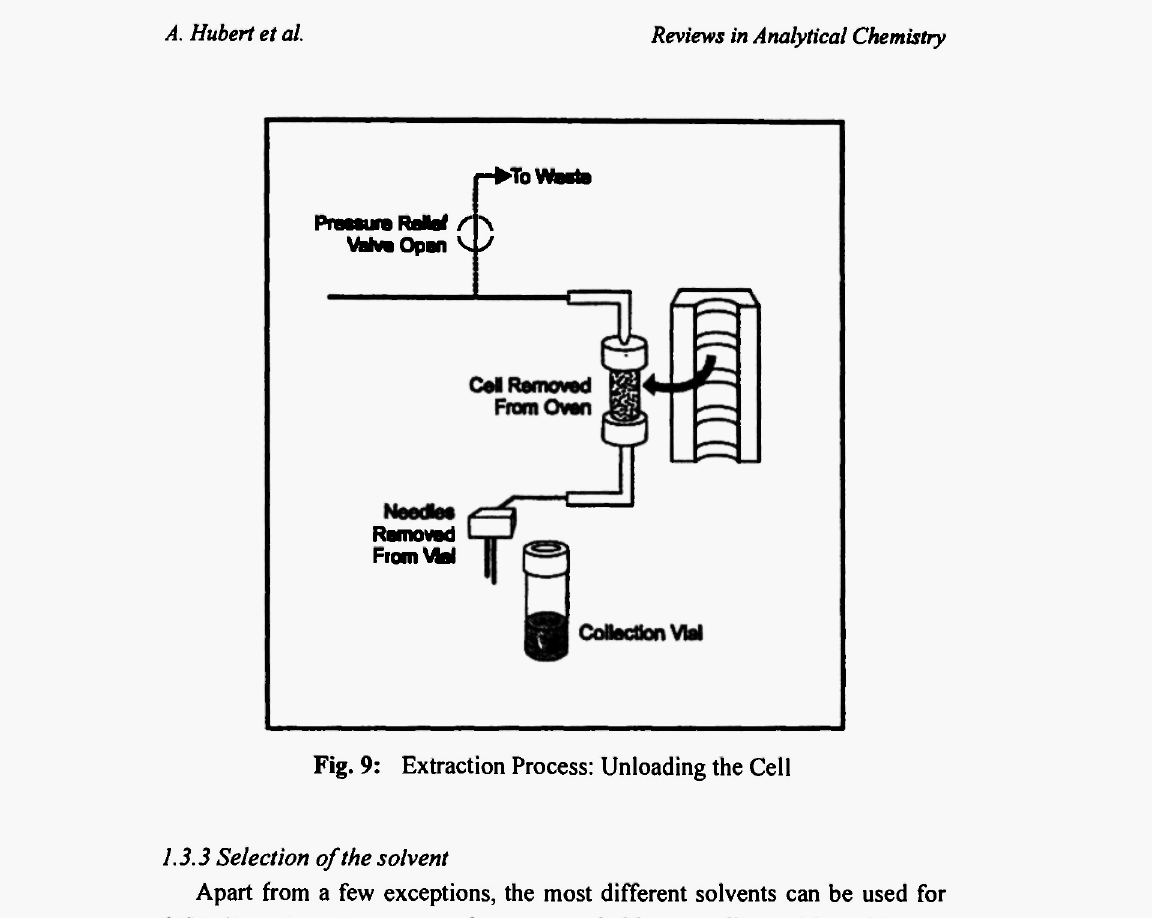
Fig. 9: Extraction Process: Unloading the